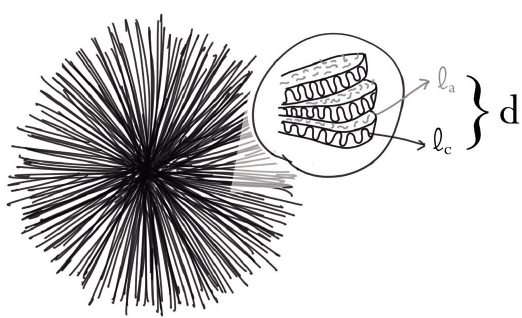
Figure 7. Ideal lamellar model showing d-spacing between adjacent crystalline lamellae. Table 4. Morphological parameters of the lamellar structure of PHB thermo-compression molded film and PHB nanofibers mat.